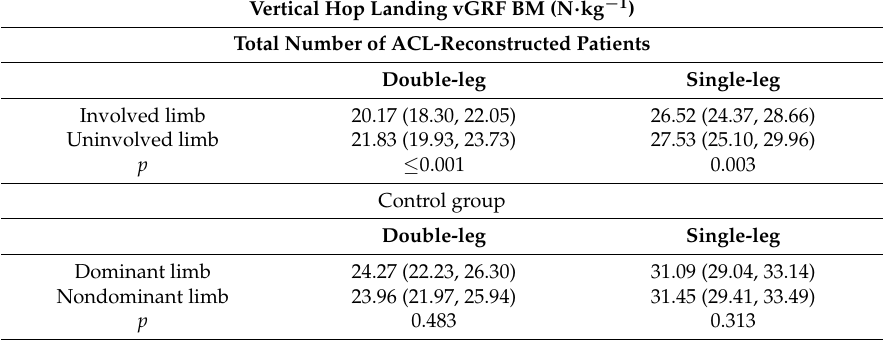
Table 2. Between-limb comparison of vertical ground reaction force values obtained during the double-leg and single-leg vertical hop landing in ACL-reconstructed patients and a control group; ACL: anterior cruciate ligament; p: level of significance of the between-limb difference; vGRF BM: vertical ground reaction force normalized to body mass. Values expressed as the arithmetic mean and 95% confidence